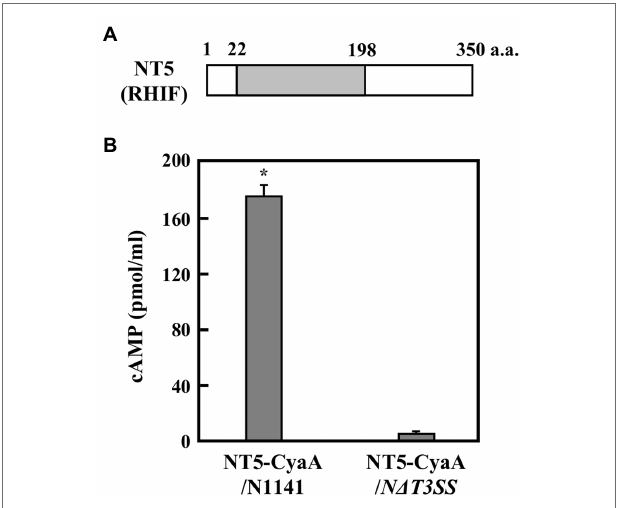
FIGURE 2 | ETI effector candidate protein NT5 (RHIF). (A) Schematic drawing of NT5 (RHIF) structure. Gray box indicates the region that is homologous to the p-loop NTPase domain within rice isopentenyl transferase10. (B) Transport of NT5 (RHIF) from N1141 into rice cells. Cultured rice cells were inoculated with A. avenae N1141 strain and N ∆ T3SS carrying pBBR1Tp plasmid expressing the NT5 (RHIF)-CyaA fusion protein, and 12 h after inoculation, cAMP concentration was measured. Bars indicate the standard deviation of three independent experiments. Asterisk indicates significant difference ( t -test, p <